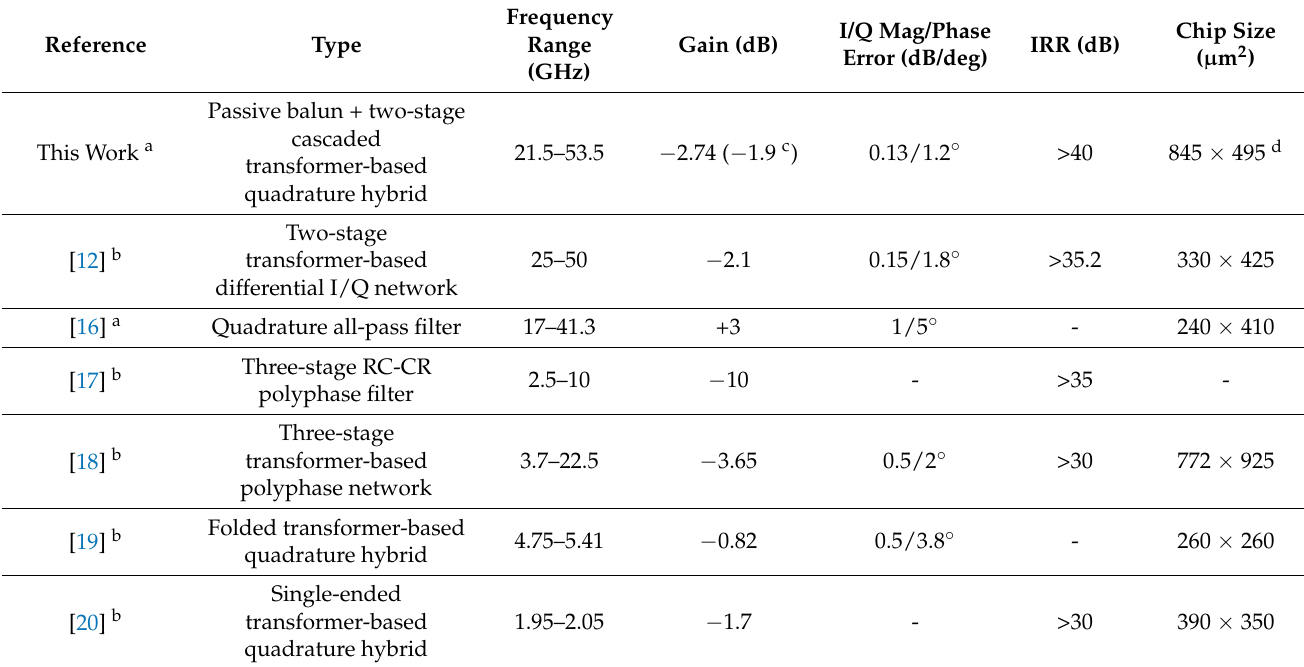
Figure 15. IRR of the proposed I/Q signal generation network. Table 1. Performance summary and